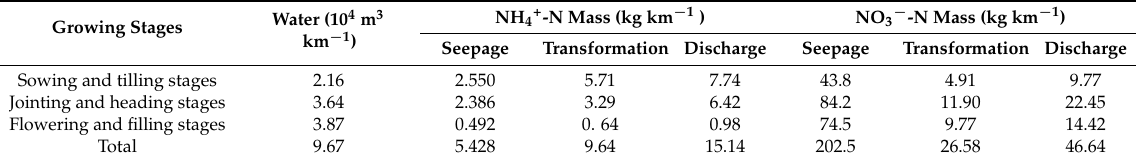
Table 5. Mass balance of non-point source pollution types during the highland barley growing